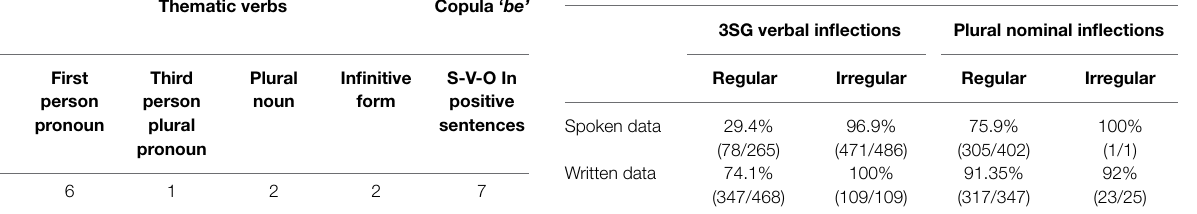
TABLE 9 | Suppliance rates of regular and irregular markings for 3SG verbs and plurals.